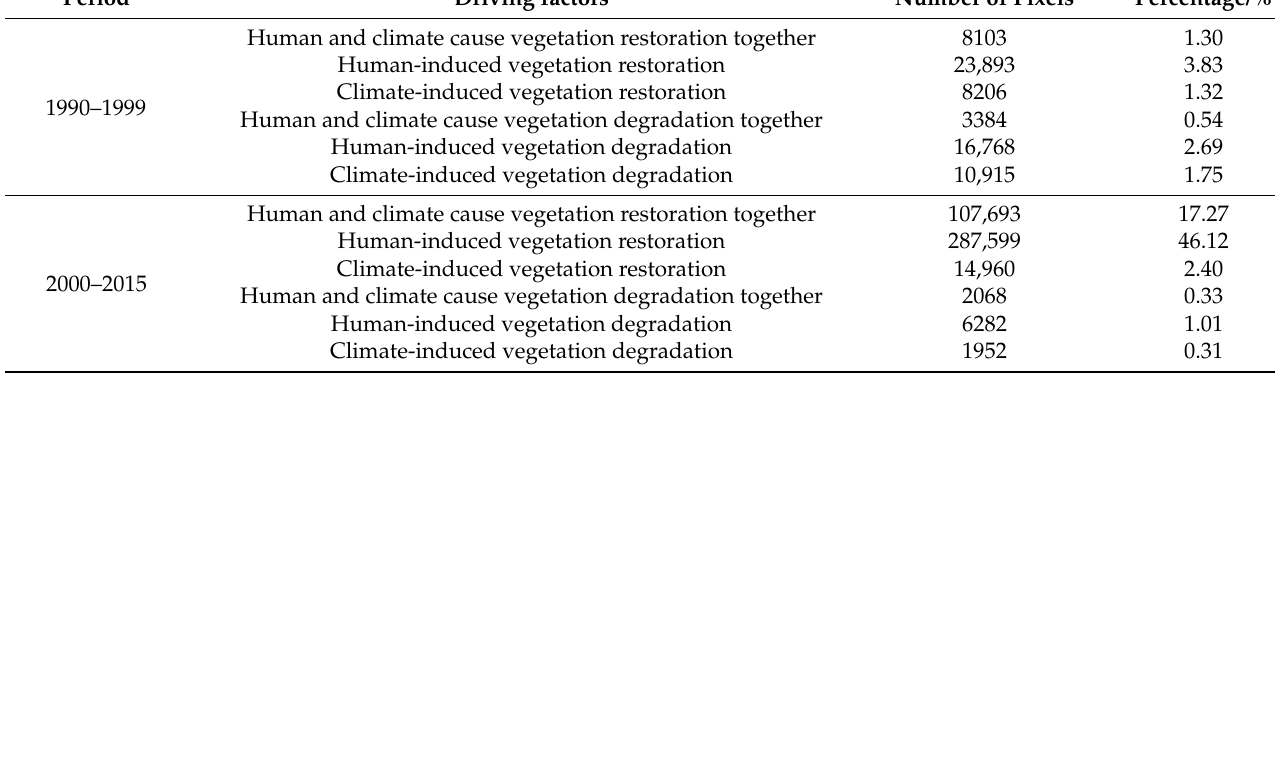
Table 10. Analysis of driving factors of vegetation-quality changes on the Loess Plateau before and after the implementation of ecological engineering.